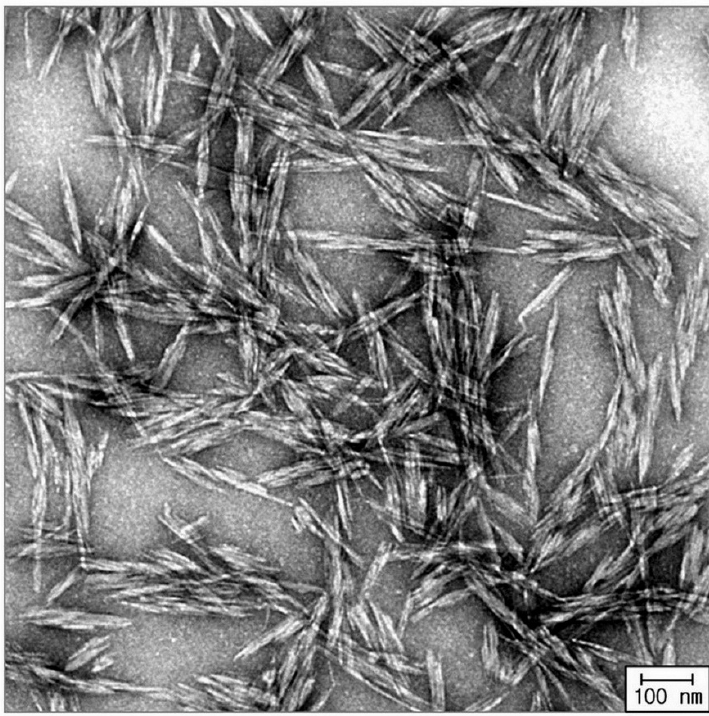
Figure 2. Transmission Electron Microscopy (TEM) image of acetylated CNW isolated from hydrolysis microcrystalline cellulose. (Copyright and permission, [29]).